Question: What visual encoding does this figure use to show its data?
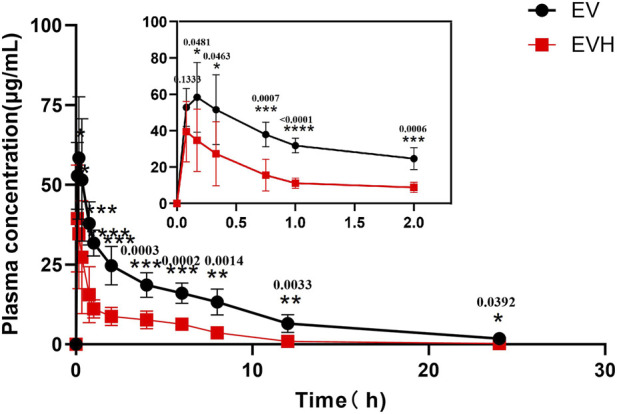
Answer: line